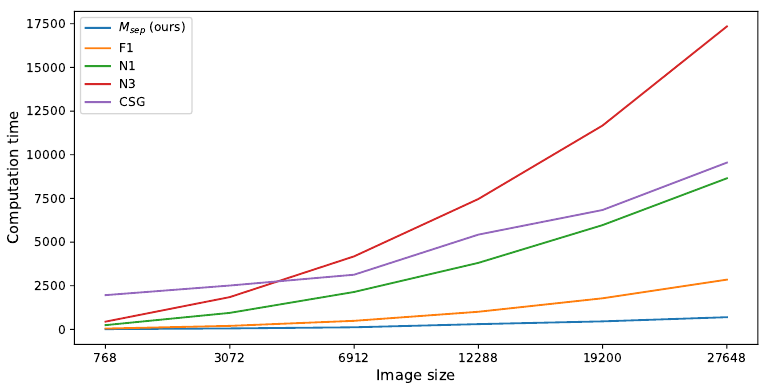
Figure 2. Data dimension vs. computation time (CIFAR10). Table 4. Data dimension vs. computation time (CIFAR10) in detail (the values in the table repre- sent seconds).